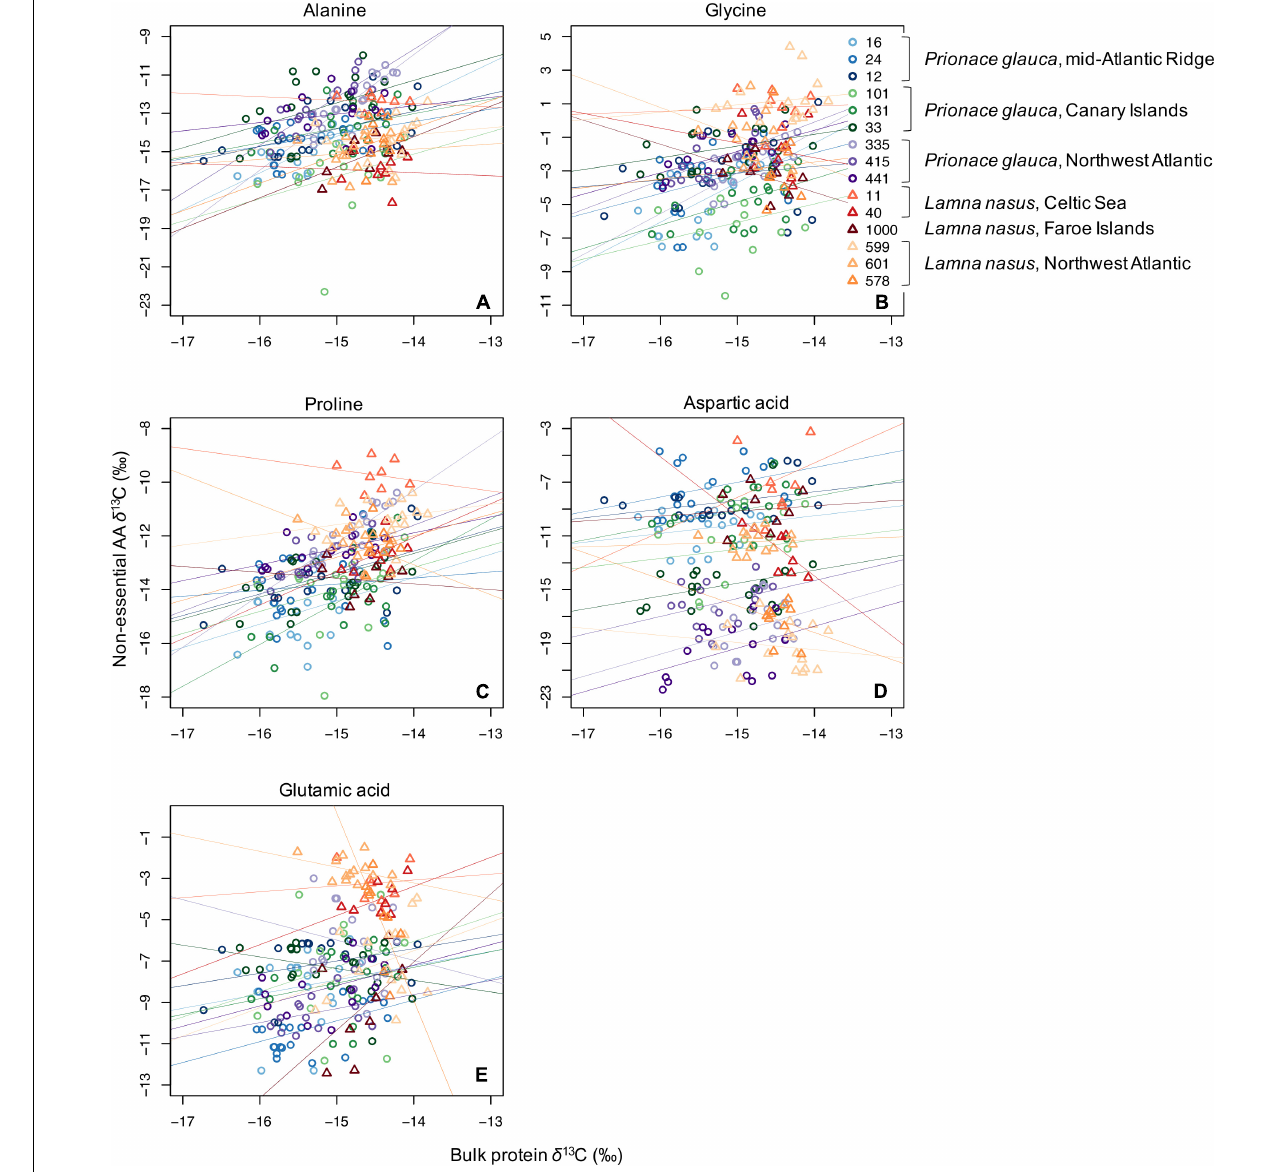
FIGURE 4 | Scatterplots of raw δ 13 C values of bulk protein vs. single non-essential amino acids ( A , alanine; B , glycine; C , proline; D , aspartic acid; and E , glutamic acid) in comparable vertebral samples from individual blue sharks and porbeagles caught across the North Atlantic (as in figure